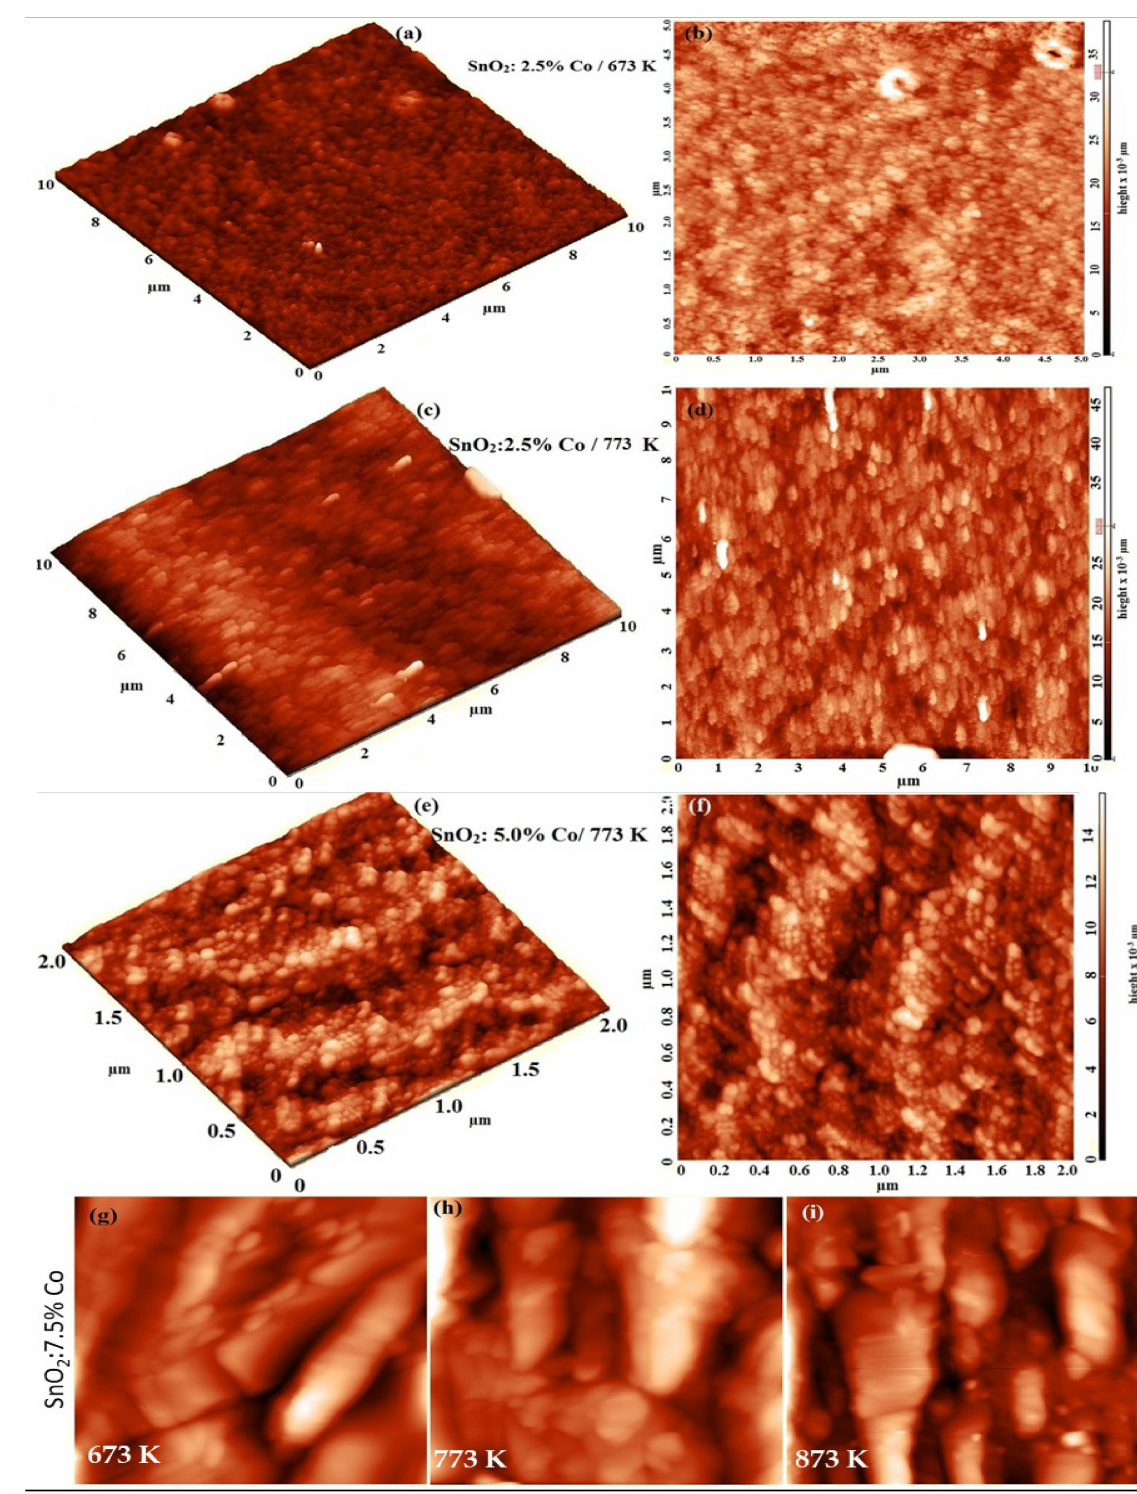
Figure 2. 3D & 2D AFM images of ( a – d ) SnO 2 : 2.5% Co at 673 K and 773 K, ( e , f ) SnO 2 : 5.0% Co at 773 K; and ( g – i ) 2D AFM images of SnO 2 : 7.5 thin films at 673, 773,and 873 K,